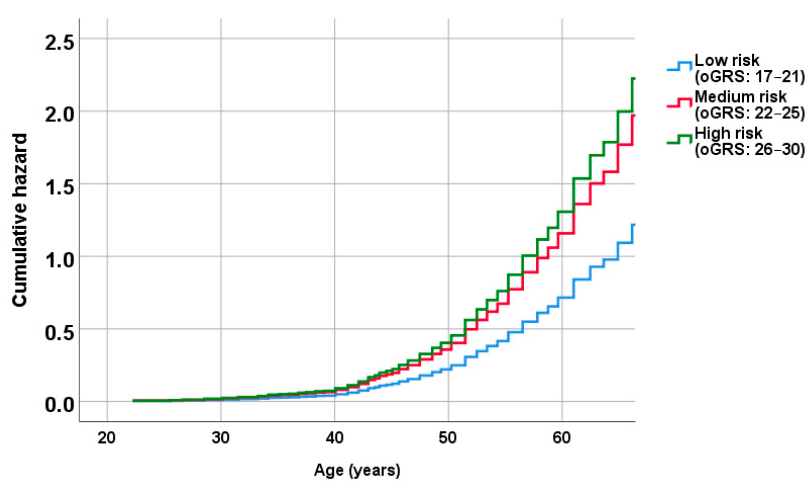
Figure 5. Cumulative risk of metabolically unhealthy obesity in relation to age in low (blue), medium (red) and high (green) genetic risk groups based on Cox regression proportional hazards model analysis.